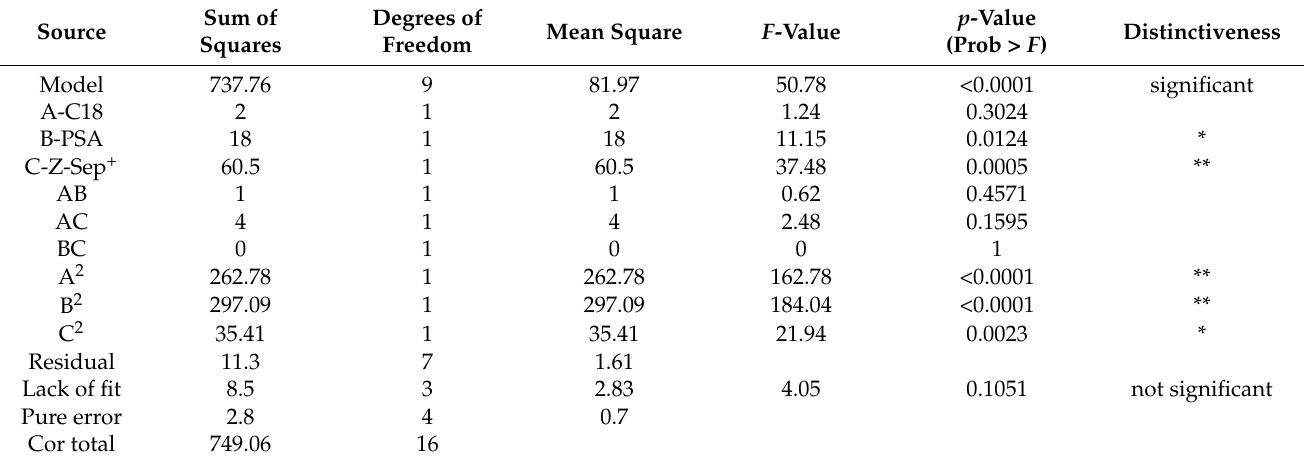
Table 1. Variance analysis of regression model of antimicrobial drugs extraction from spiked samples.